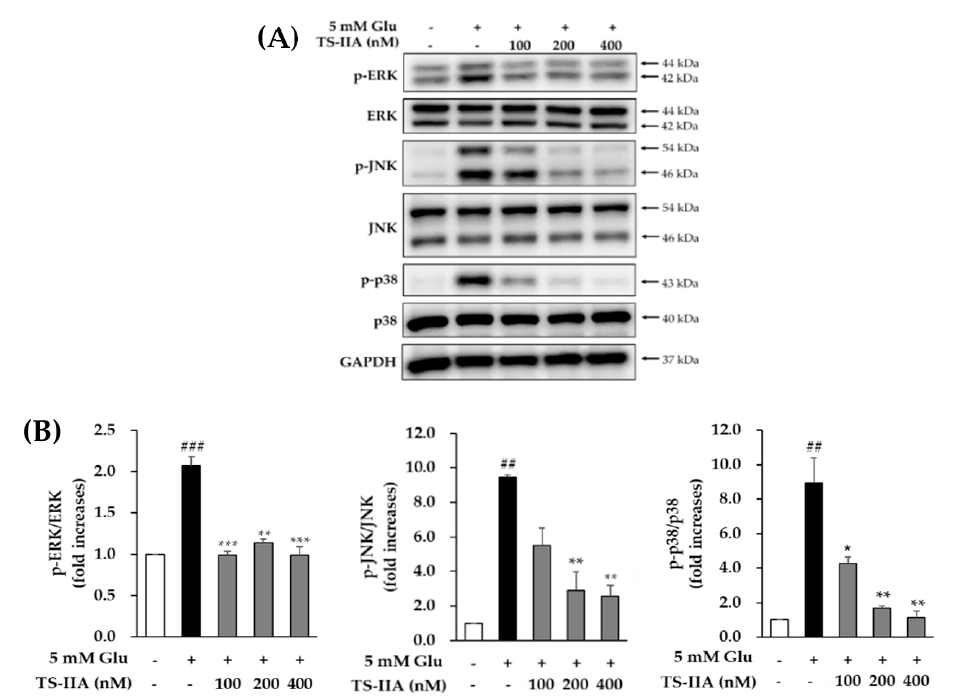
Figure 4. E ff ect of tanshinone IIA (TS-IIA) on glutamate-induced phosphorylation of MAPKs. ( A ) HT-22 cells were exposed to 100, 200, or 400 nM TS-IIA in the presence or absence of 5 mM glutamate for 12 h, and analyzed by immunoblotting to determine the immunoreactive bands for p-JNK, JNK, p-ERK, ERK, p-p38, p38, and GAPDH (Glyceraldehyde-3-Phosphate Dehydrogenase). ( B ) The bar chart describes the fold-increase of the phosphorylation of MAPKs compared with the control ( N = 2). Notes: ## p < 0.01 and ### p < 0.001 compared with the untreated group, * p < 0.05, ** p < 0.01, and *** p < 0.001 compared with the glutamate-treated group. (TS- IIA: tanshinone IIA, Glu: glutamate). In contrast to p53, Akt (protein kinase B) stimulates cell survival by inhibiting apoptosis through the phosphorylation and inactivation of several targets, including forkhead transcription factors [48], c-Raf [49], and caspase-9 [50]. The previous studies indicated that activation of PI3K / Akt